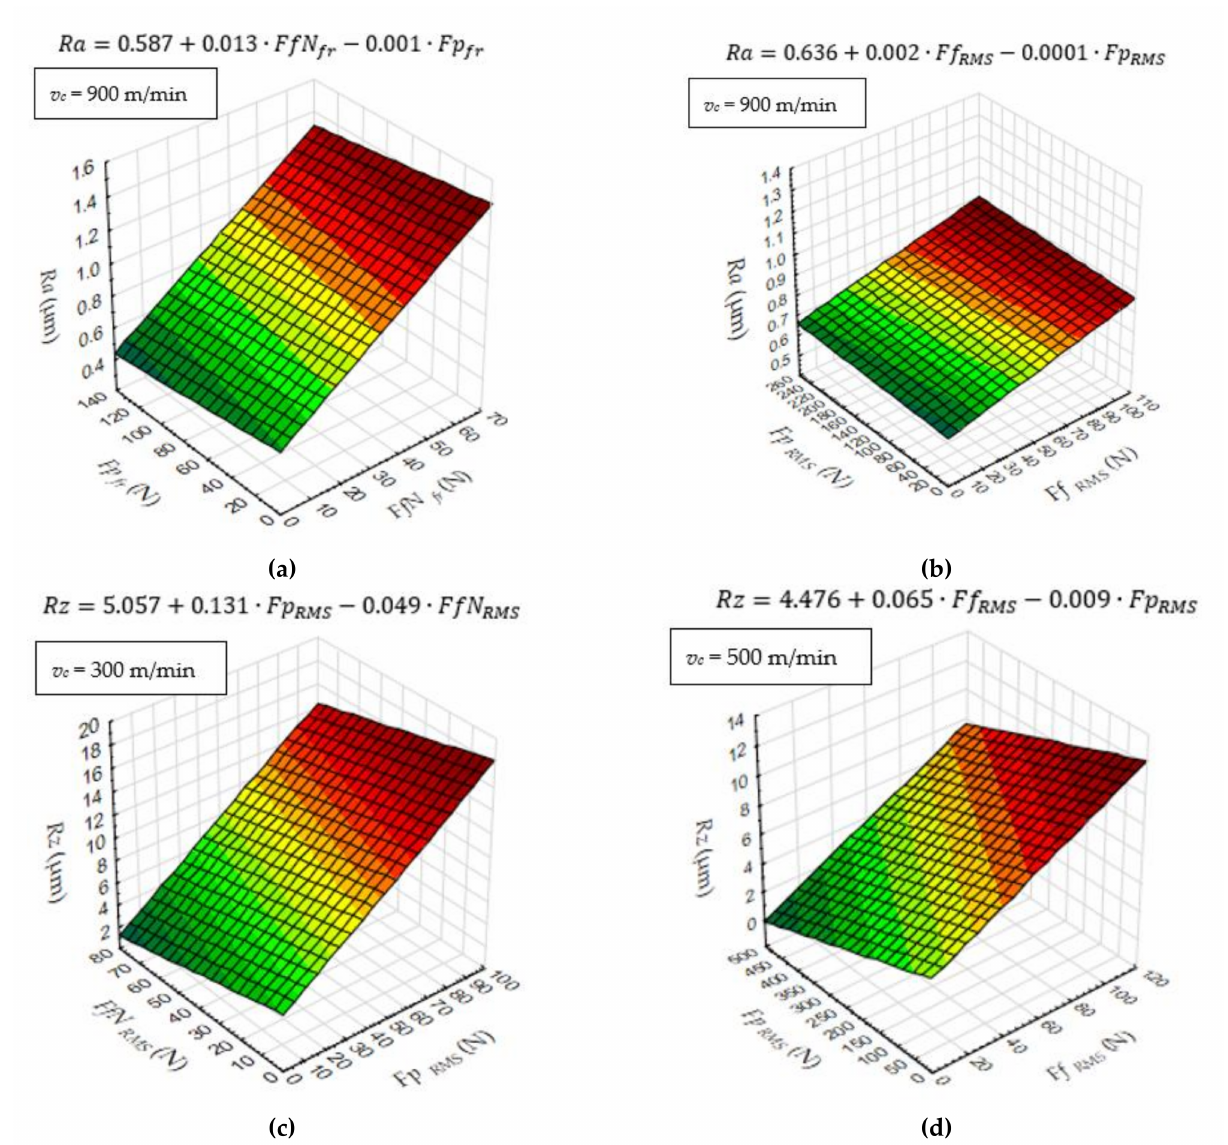
Figure 9. Three dimensional surface plot, ( a ) Ra dependence on Fp fr and FfN fr , ( b ) Ra dependence on Fp RMS and Ff RMS , ( c ) Rz dependence on FfN RMS and Fp RMS , ( d ) Rz dependence on Fp RMS and Ff RMS